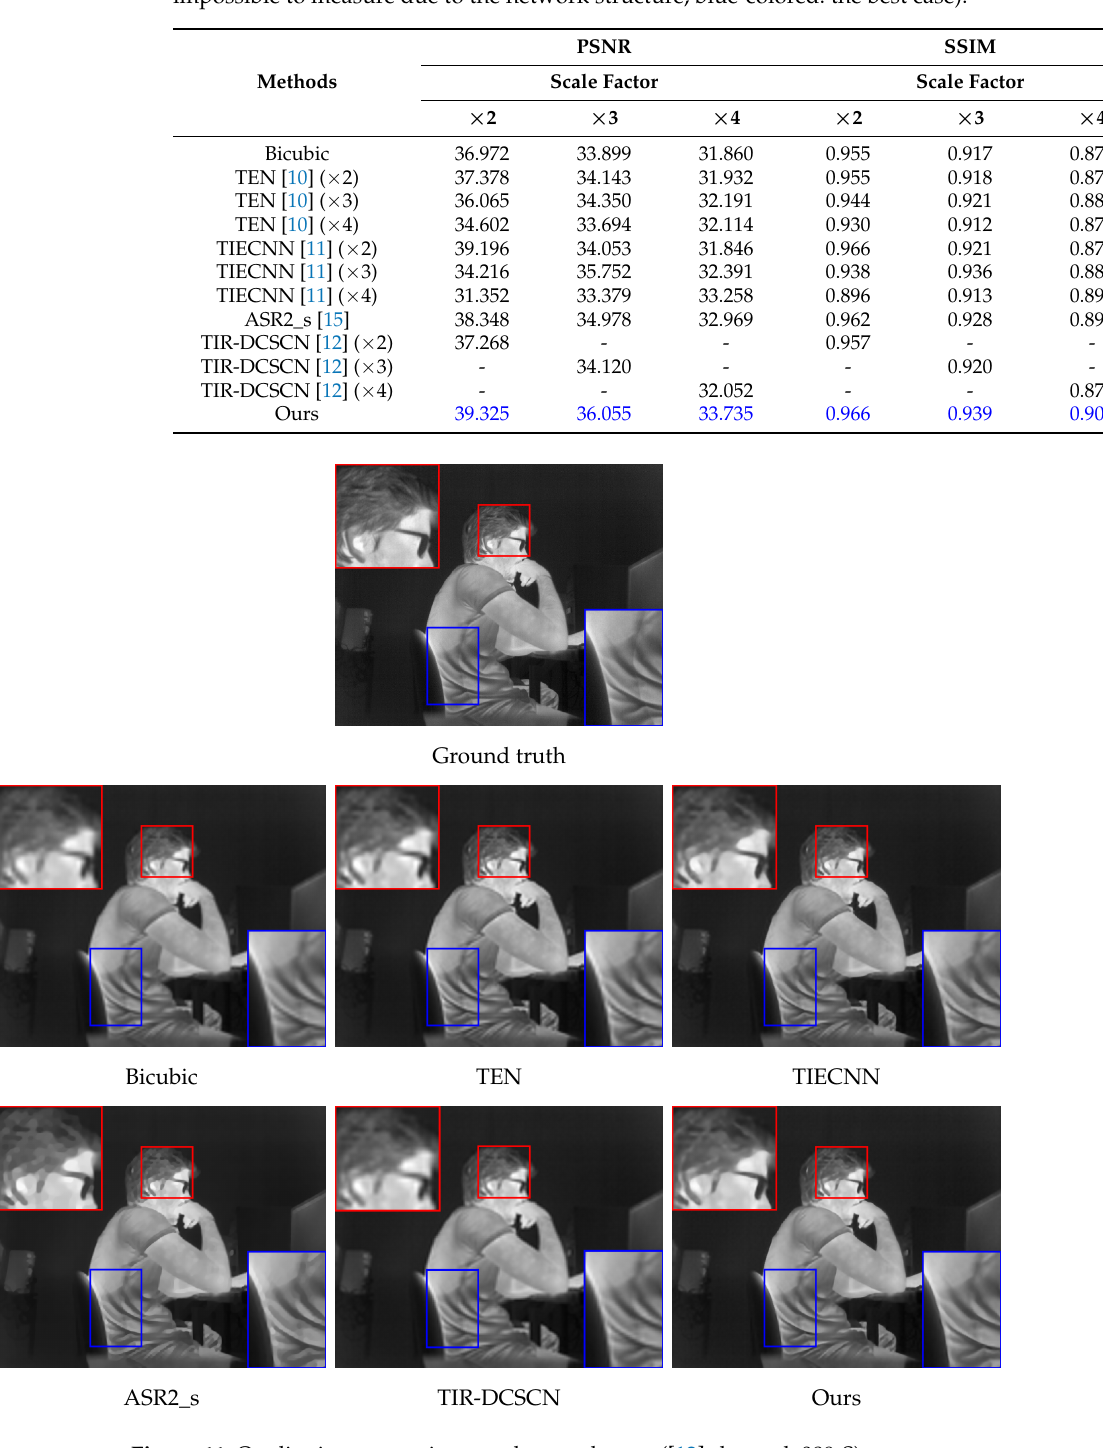
Figure 11. Qualitative comparison on the test dataset